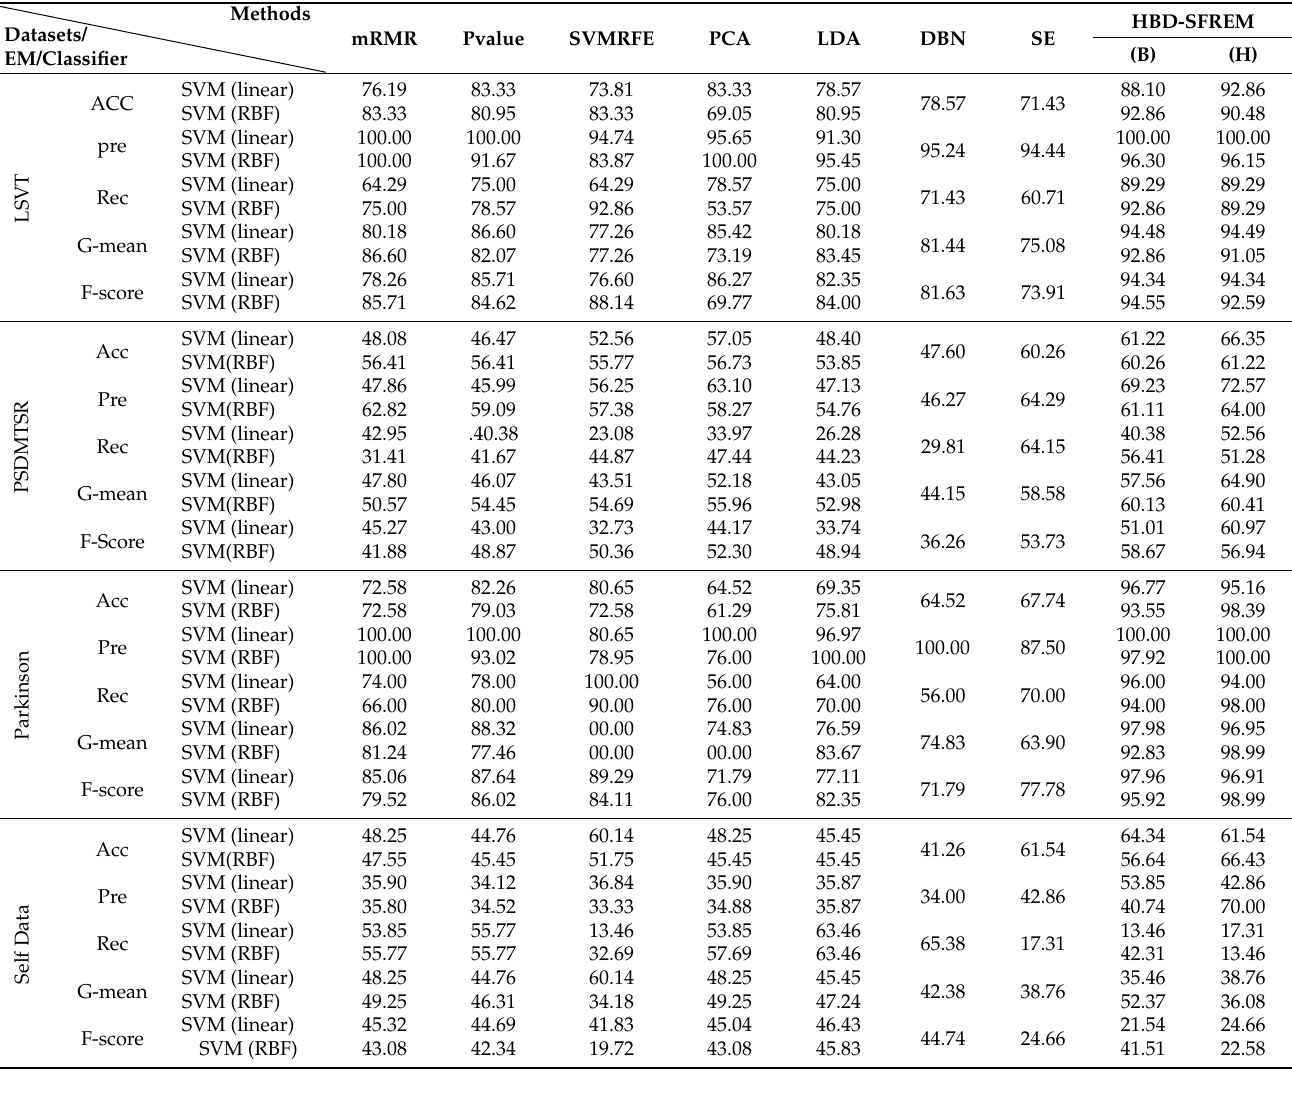
Table 7. Comparison with representative feature processing algorithms (%).